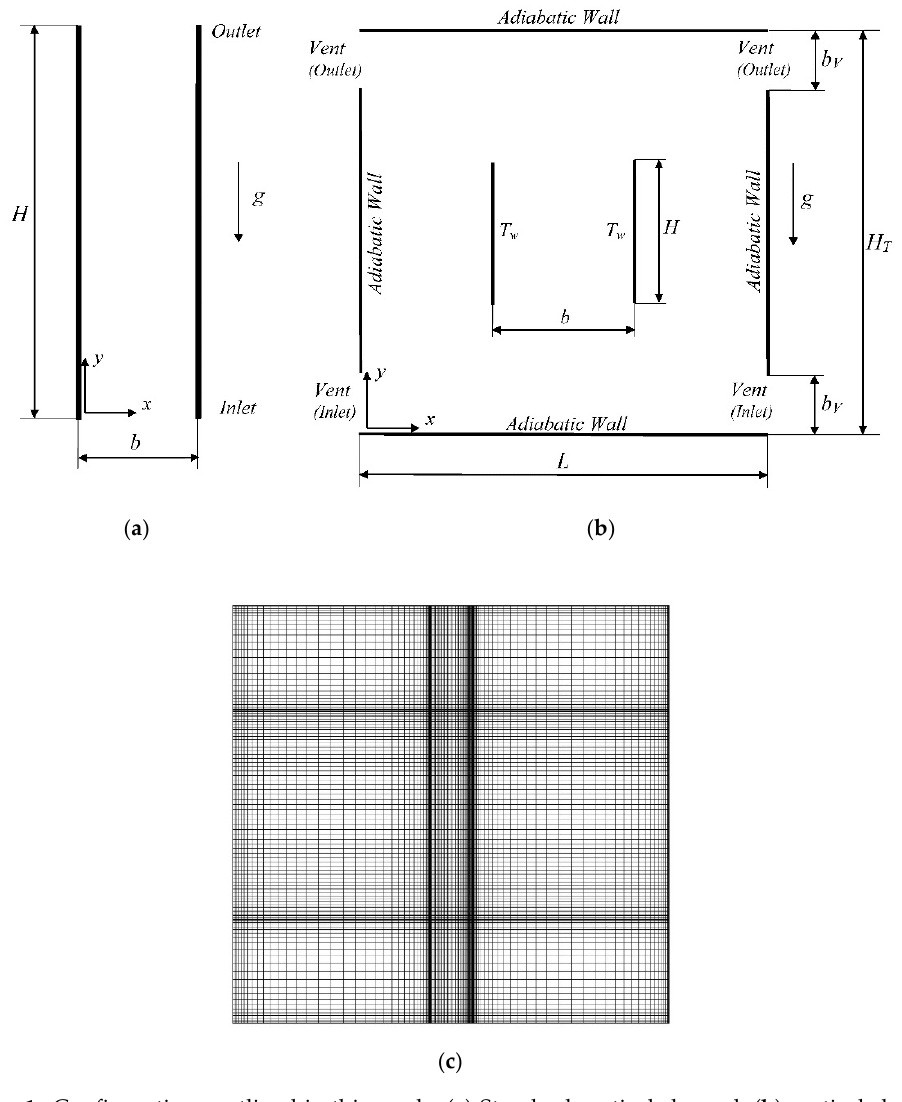
Figure 1. Configurations outlined in this work. ( a ) Standard vertical channel; ( b ) vertical channel immersed on a vented cavity; ( c ) typical computational grid employed in the simulations.